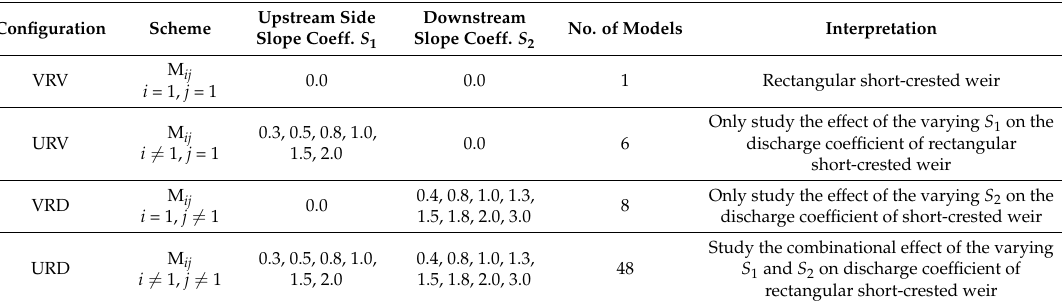
Table 2. List of design schemes of numerical simulation.